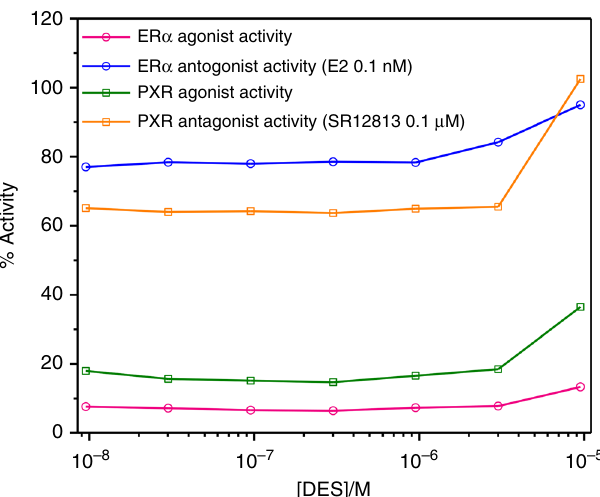
aggregates were formed. Further studies would be warranted at higher concentrations, but this is beyond the scope of current